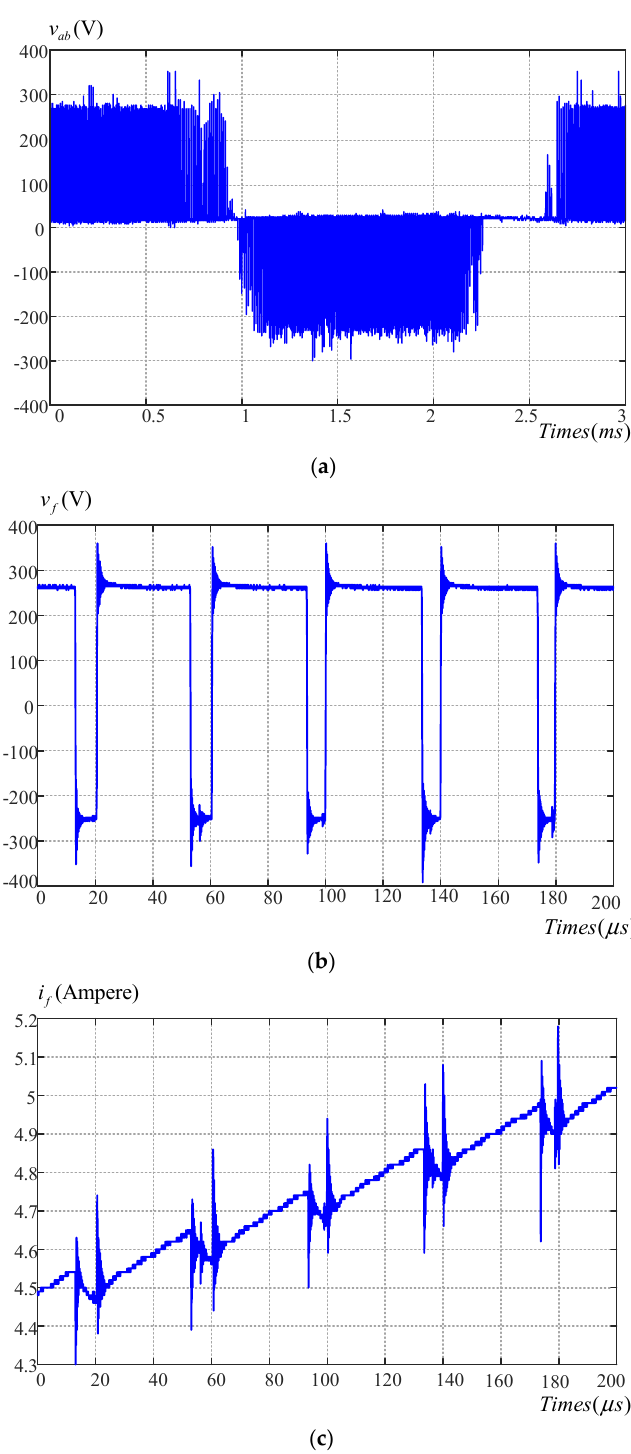
Figure 17. Measured highest, middle, and lowest operational speeds. ( a ) Highest speed, ( b ) middle speeds, and ( c ) lowest speed.